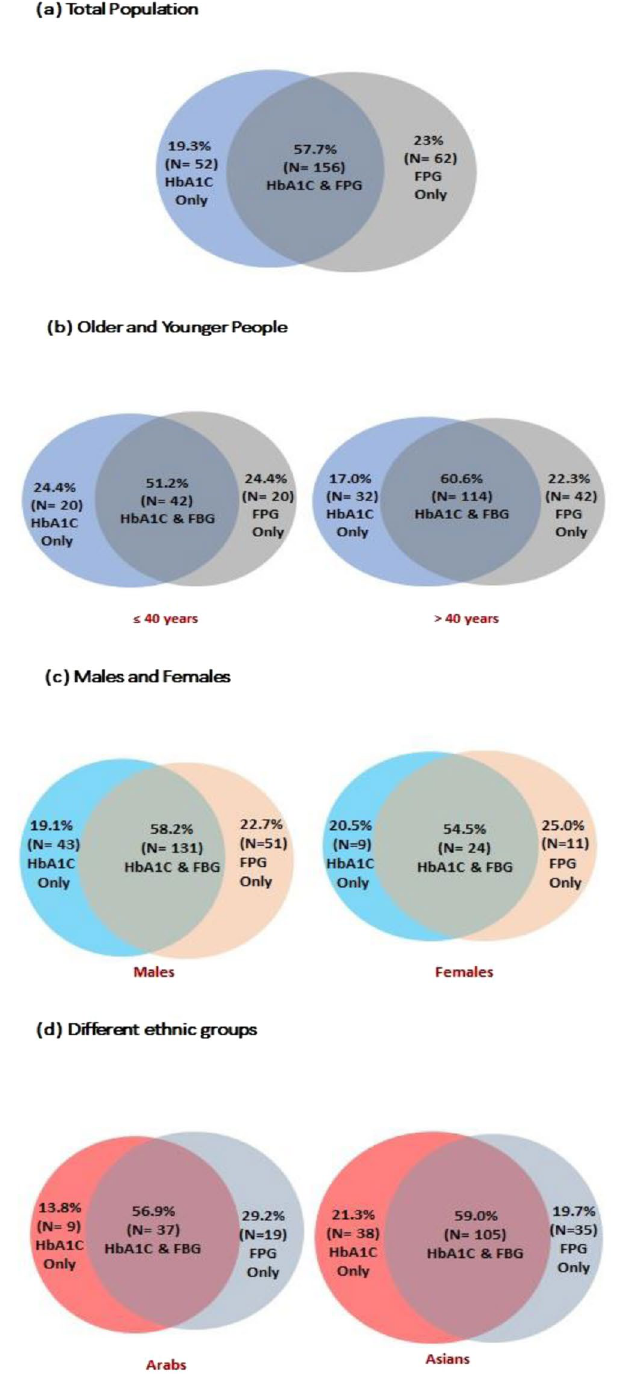
Figure 2. Distribution of cases of newly diagnosed diabetes according to FpG FPG and HbA1c in ( a ) Total total population, ( b ) older and younger people, ( c ) males and females and ( d ) Arabs and